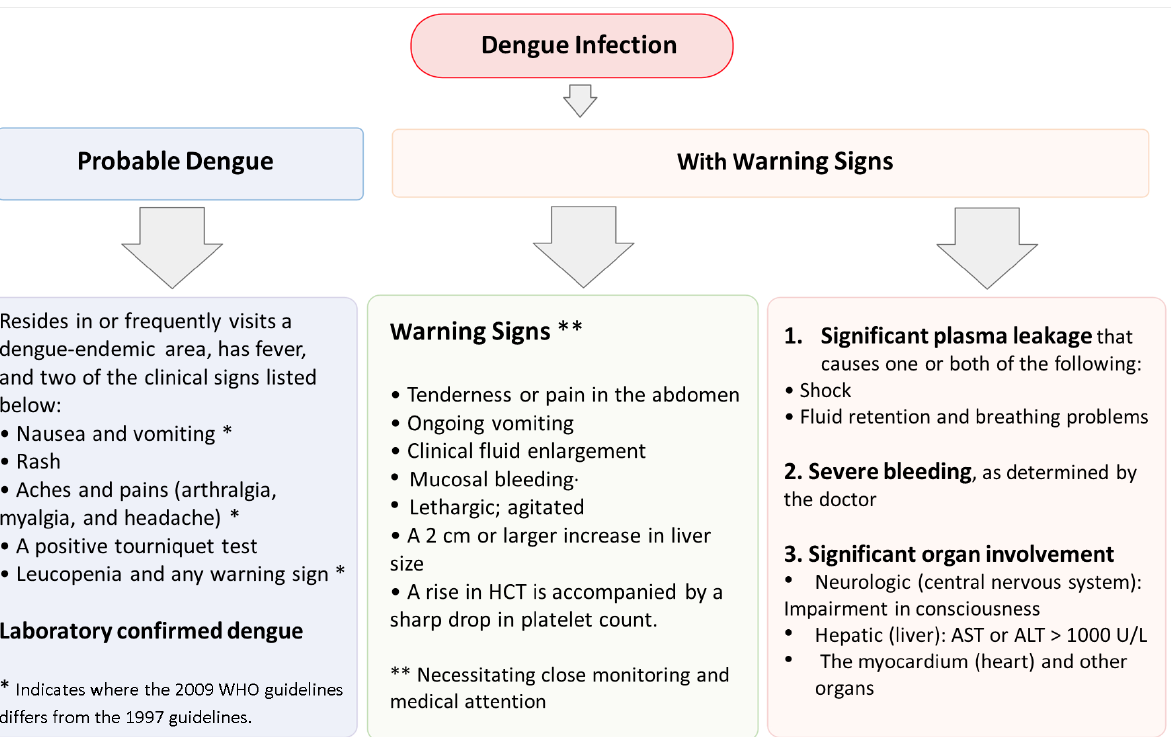
Figure 3. Clinical presentation of dengue infection and features: The clinical signs of dengue are outlined in the figure, as per classification based on WHO dengue guideline—2009. (Adapted from Dengue, Guidelines for Diagnosis, Treatment, Prevention and Control, WHO/TDR).